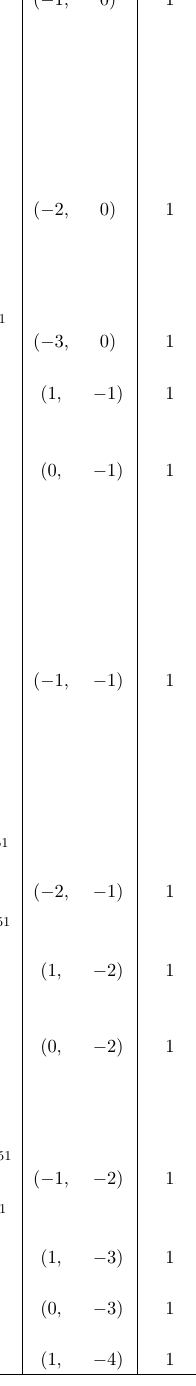
Table 22 . The generators in terms of bifundamental chiral fields for Model 5 (Part 2)